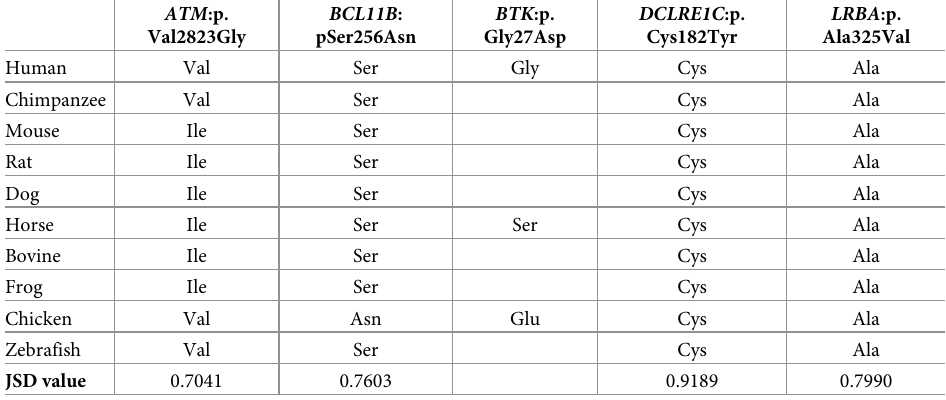
Table 2. Sequence alignment of protein sequences at positions of the missense variants with the Jensen-Shannon divergence (JSD) values. ATM :p. BCL11B : BTK :p. DCLRE1C :p. Val2823Gly pSer256Asn Gly27Asp Cys182Tyr